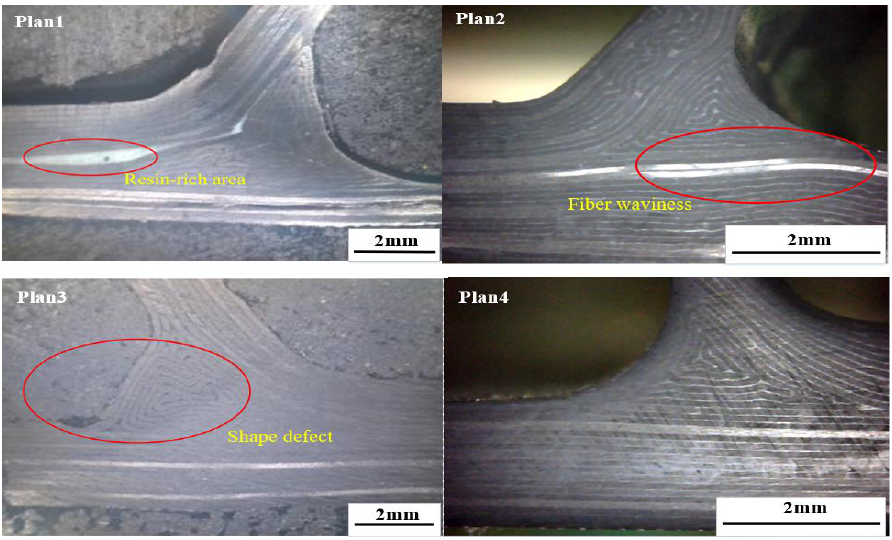
Figure 9. Contrast between fiber distributions with different filling form.